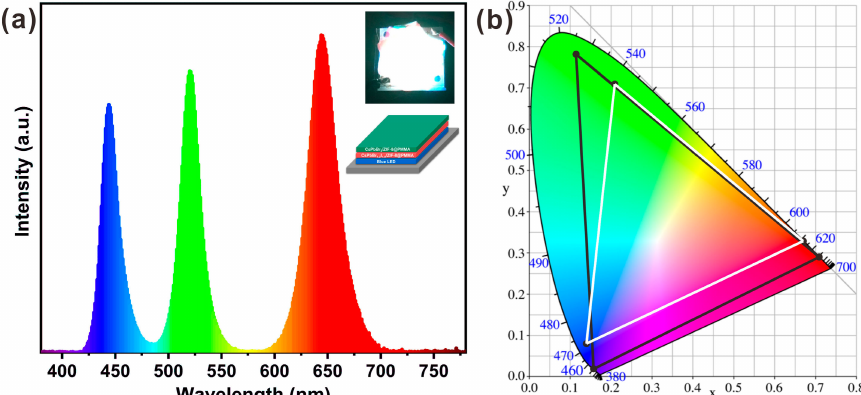
( a ) PL spectrum of a remote-type white LED fabricated by covering a green CsPbBr 3 / ZIF-8@PMMA film and a red CsPbBr 1.2 I 1.8 / ZIF-8@PMMA film on a blue chip. Inset: Photograph and configuration schematic diagram of the white LED. ( b ) Color gamut of the white LED (black line) compared with the National Television System Committee (NTSC) standard (white